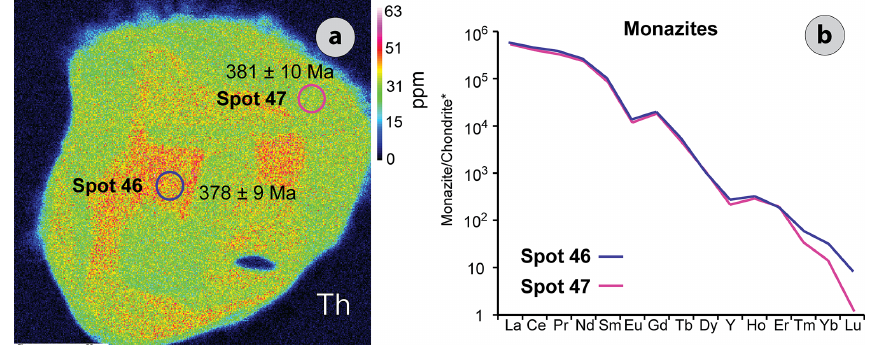
Figure 5. (a) Monazite grain compositional maps in paragneiss with a 30% thorium variation. Location and spot numbers (46 and 47) are indicated, as well as the 206 Pb / 238 U age and error ( ± 2 σ ). (b) Chondrite-normalized REE patterns for the same monazite in panel (a) .